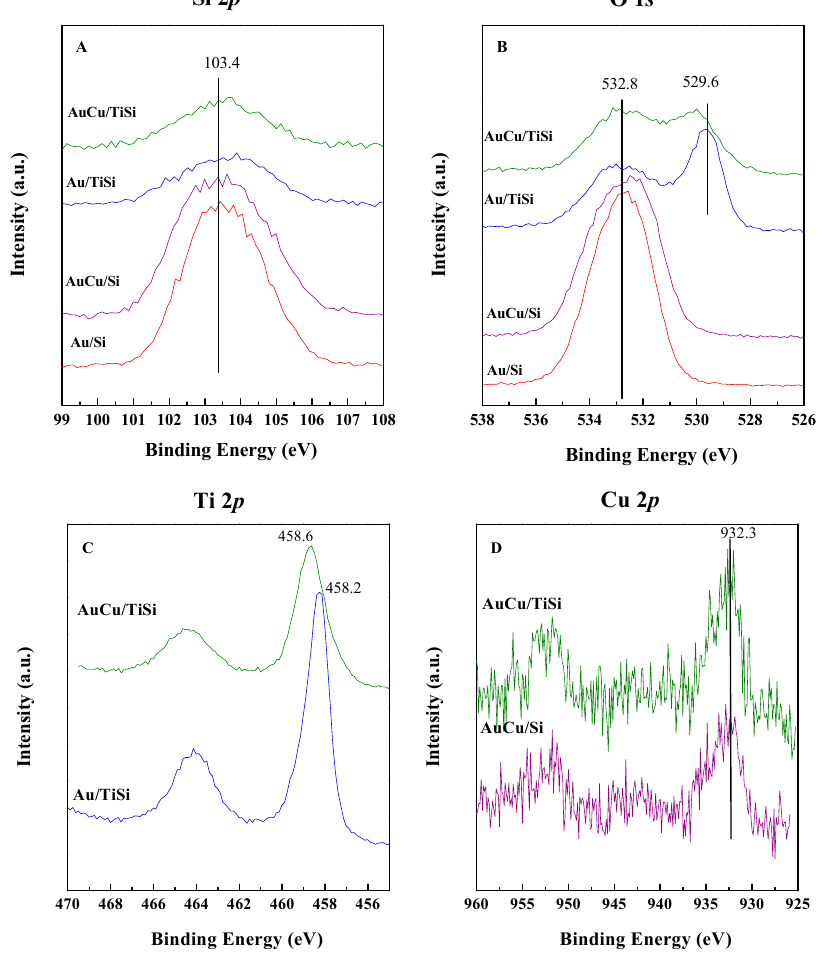
Figure 6. Si 2 p ( A ), O 1 s ( B ), Ti 2 p ( C ), and Cu 2 p ( D ) core level spectra of the samples.